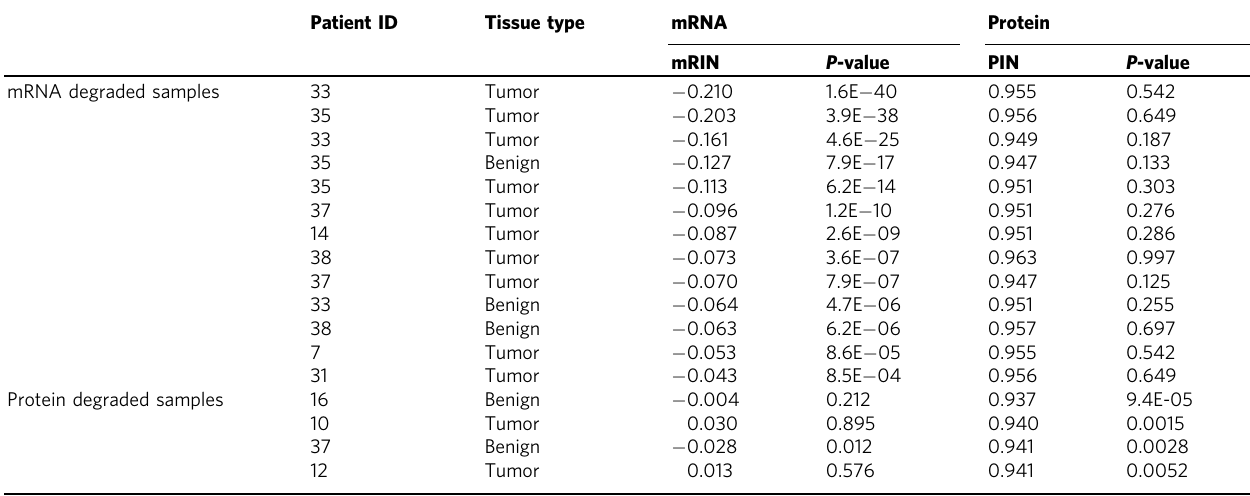
Table 2 mRINs and PINs with their associated P -values of the degraded prostate